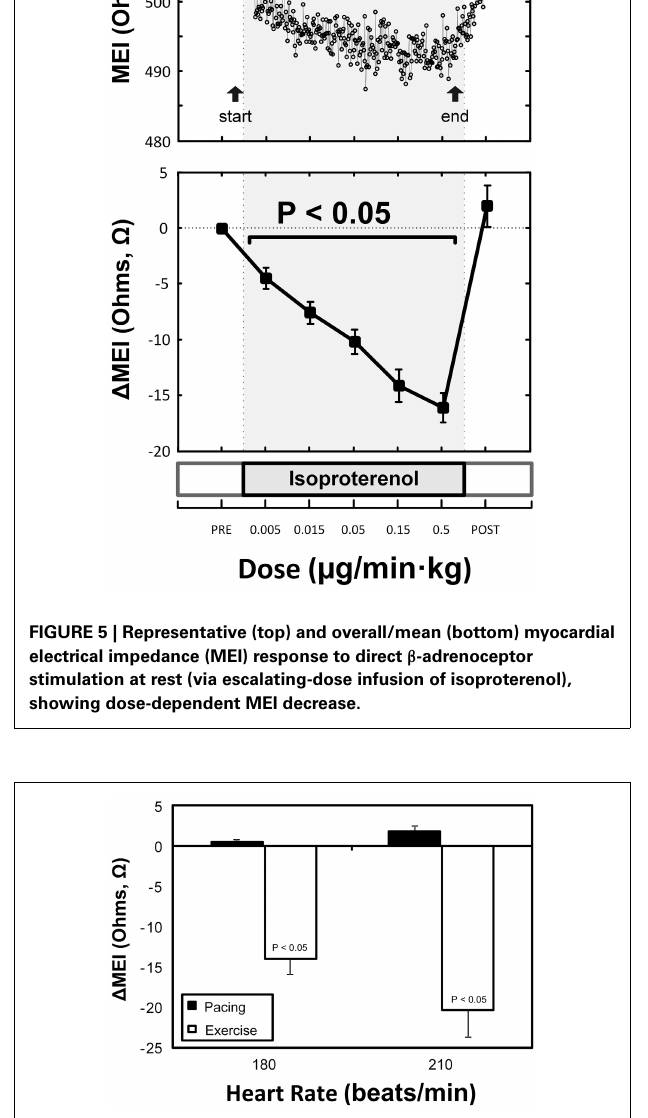
FIGURE 6 | Comparative myocardial electrical impedance (MEI) response to either submaximal exercise (white) or acute rate-matched ventricular pacing (black); only exercise decreased